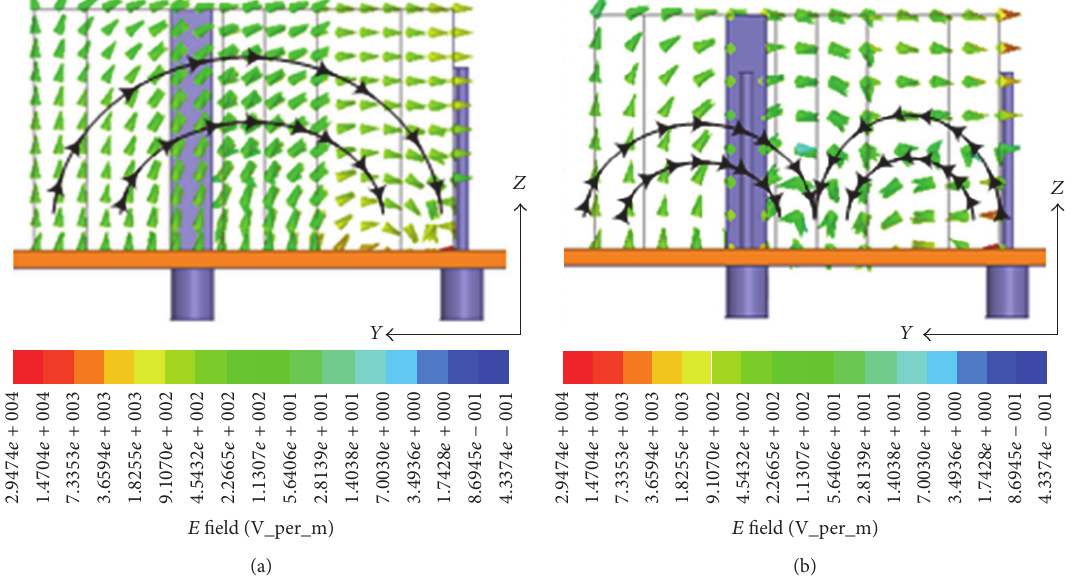
Figure 2: Electric field patterns of port 1: (a) 1.47 GHz and (b) 2.31 GHz.